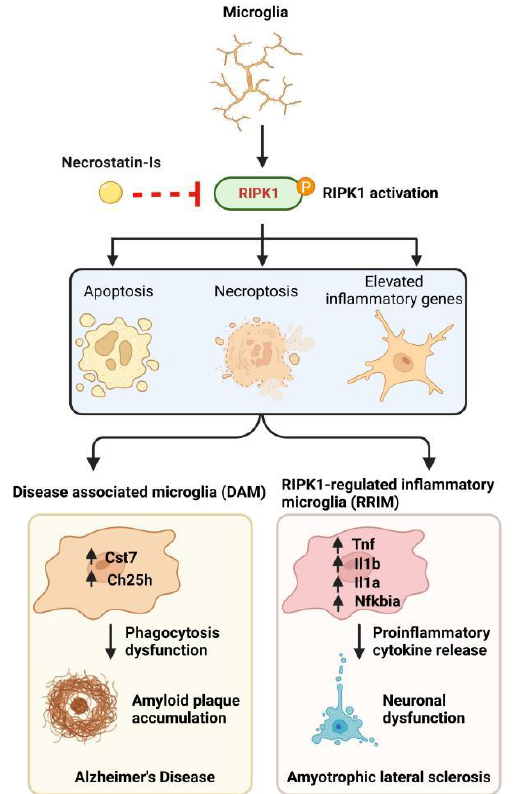
Figure 2. Activated RIPK1 promotes microglial apoptosis, necroptosis, and inflammatory response. In vitro, cell death-inducing agents stimulate RIPK1 kinase activity-dependent apoptosis, necroptosis, and inflammatory responses in microglia, all of which could be inhibited by the RIPK1 kinase activity inhibitor Nec-1s ( Upper ). In vivo, the inhibition of RIPK1 kinase activity ameliorates the DAM phenotype in AD and RRIM phenotype in ALS, respectively ( Lower ).